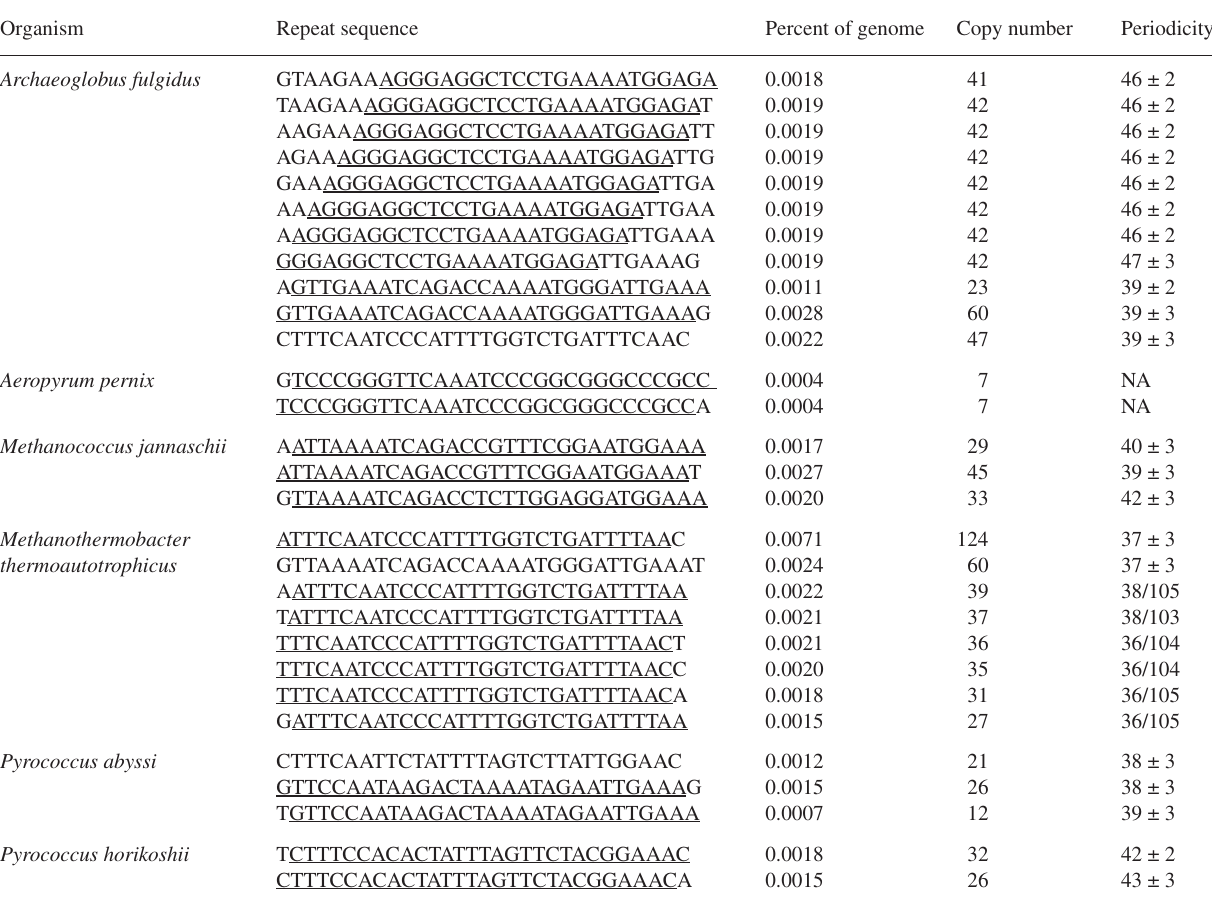
Table 2. The most common 30 bp repeats with a narrow range of periodicity in different archaeal genomes. Repeats that recur more than 20 times in tandem are considered high-order repeats. The proportion of the sense strand of the genome represented by these repeats (percent of genome), the absolute number (copy number) and the mean ± SD spacer length between consecutive repeats, excluding outliers (periodicity; bp), are given. Where repeat sequences occur in two locations within the genome, mean periodicity of both locations are given. Underlined fragments depict common repetitive elements within each